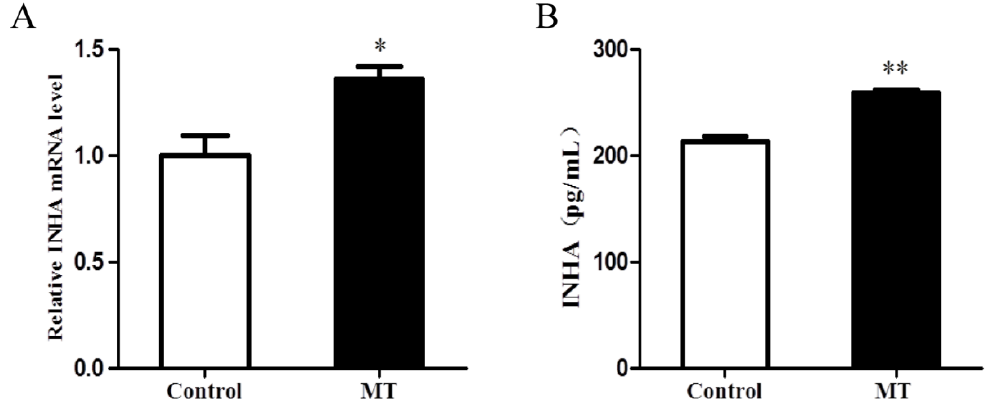
Figure 3. Effects of melatonin (1 000 nM) on the INHA expression of chicken Sertoli cells. ( A ) Relative mRNA expression levels of INHA and ( B ) INHA measured by ELISA (n = 3). ** P < 0.01; * P < 0.05.